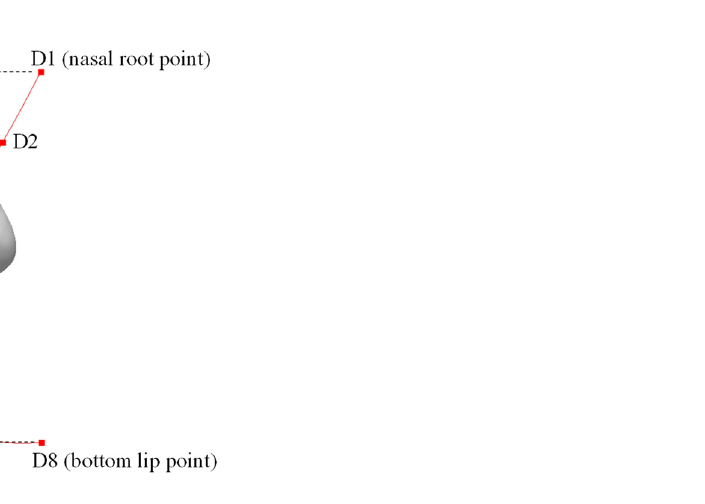
Figure 6. Projection of design landmarks of the existing MBU-20/P mask onto a representative face of the Korean Air Force (KAF) pilots (red ■ : design landmarks of MBU-20/P specified by Gross et al. [15] ; blue ⬤ : projected design landmarks on the face surface; ×: facial landmarks).